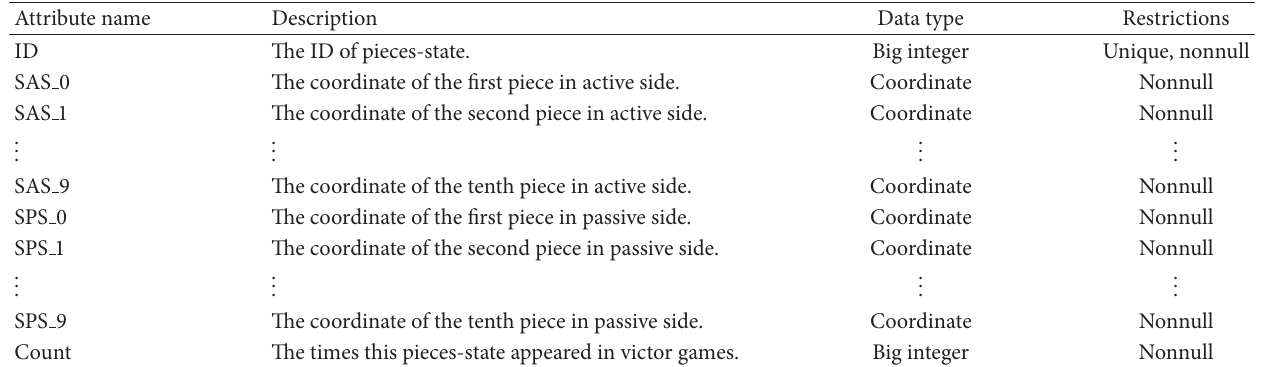
Table 1: Attributes of the PiecesState .